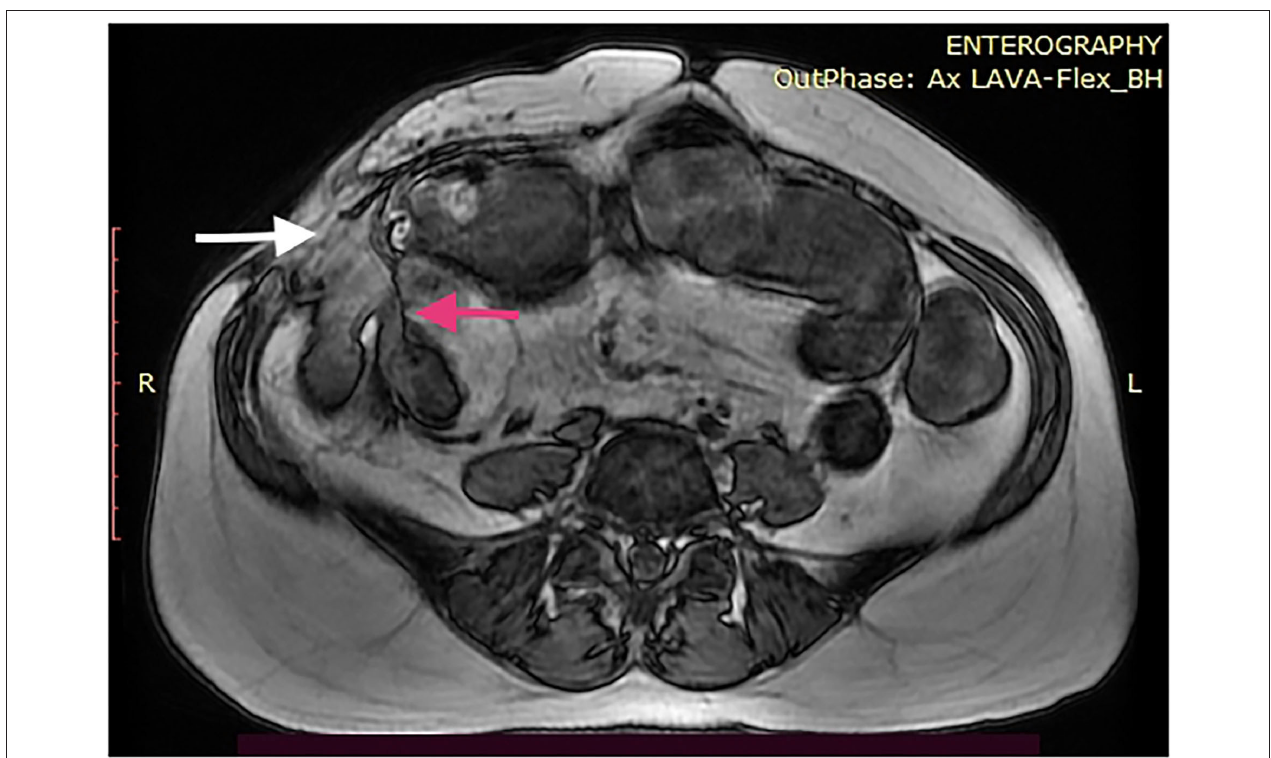
FIGURE 1 | MRI enterography of a 46-year-old woman with CD with an enterocutaneous fistula (ECF) at the right iliac fossa (white arrow). She has undergone two ileocolic resections previously and a stricturoplasty of the end to end anastomosis within a 7-year period. The image demonstrates proximal bowel dilatation and a possible distal stricture (red